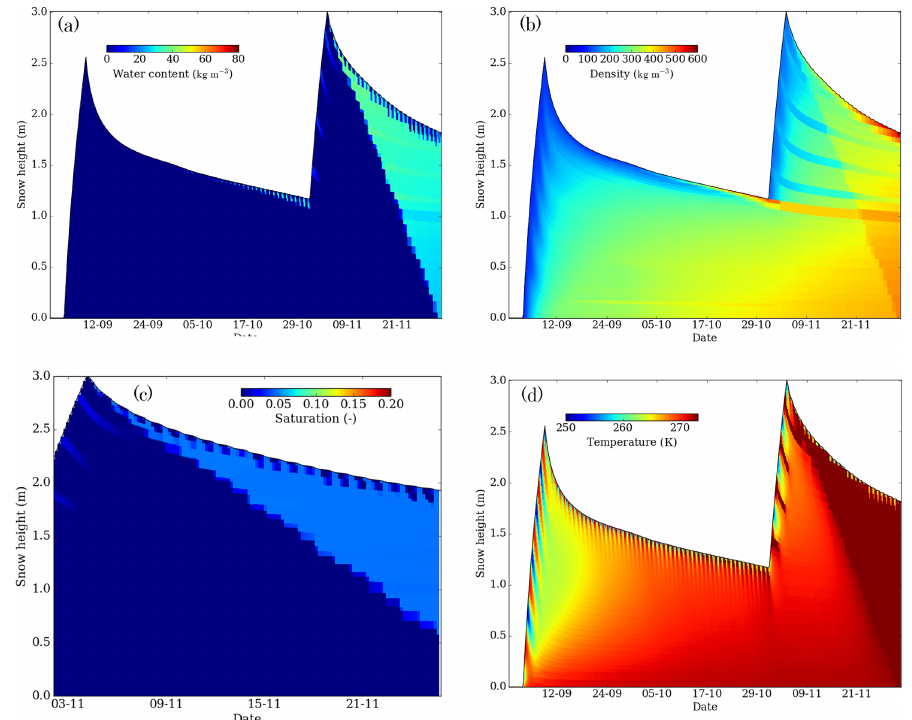
Figure 7. Crocus output for simulated forcing using the bucket routine with T Crocus = 900s (15min), plotted every 3h, except for (c) , which is plotted every 15min. (a) Liquid water amount, (b) snow layer density, (c) percentage of pore volume filled with water zoomed in on the second snow event and (d) temperature development of the